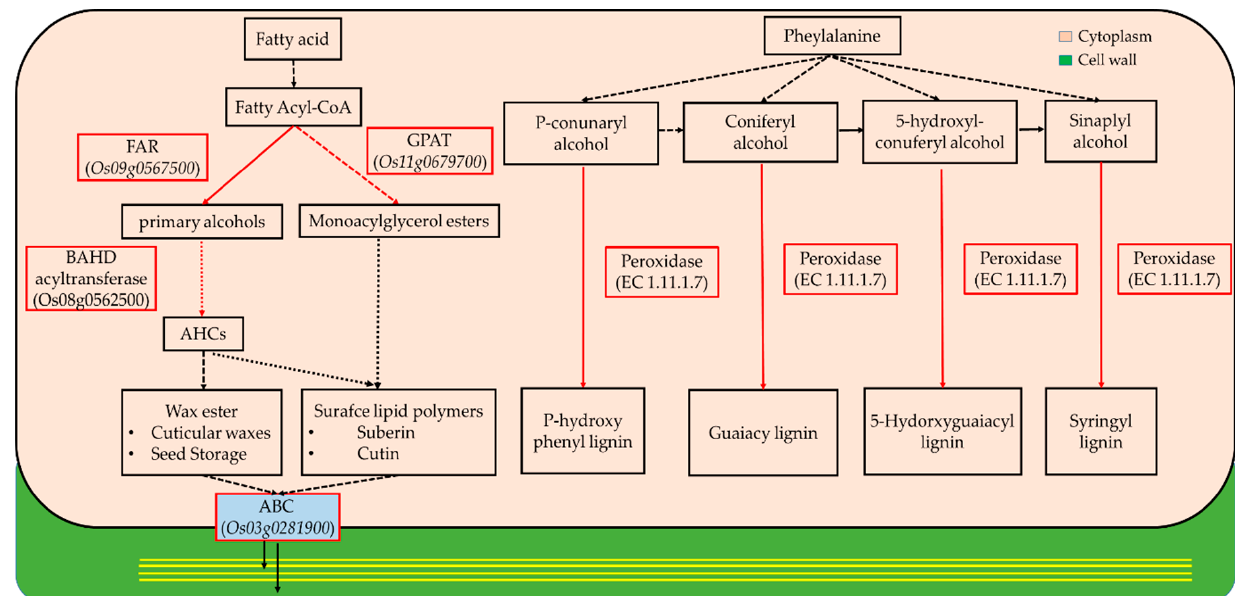
Figure 4. Simplified coordination process for secondary cell wall organization in plants. In the present study, genes in red boxes were highly upregulated during the source stage in the blades. FAR (fatty acyl-CoA reductase); GPAT (glycerol-3-phosphate acyltransferase); BAHD (benzyl alcohol O -acetyltransferase, anthocyanin O -hydroxycinnamoyltransferase, N-hydroxycinnamoly/benzoyltransferase and deacetylvindolin 4- O -acetyltransferase); ABC (ATP-binding cassette). Table 3. Concentrations of selected soluble carbohydrates at the sink-to-source, source, and sink stages in the blades (mean ± S.D.).